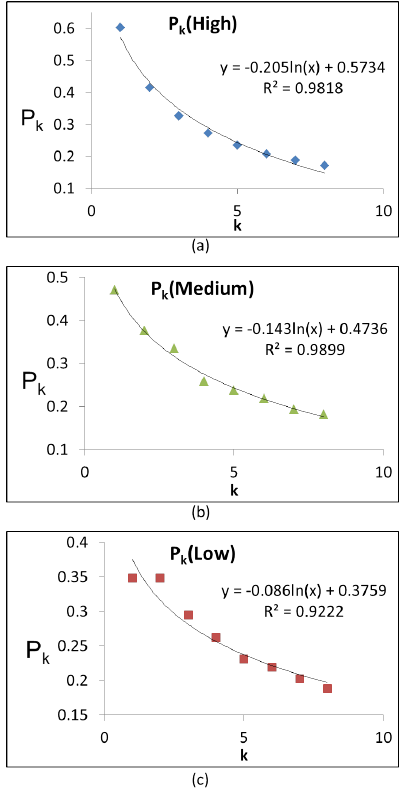
Figure 5. P k trend and correlation for High, Medium and Low cases. ( a ): Plot and trend of ’High’ case. ( b ): Plot and trend of ’Medium’ case. ( c ): Plot and trend of ’Low’